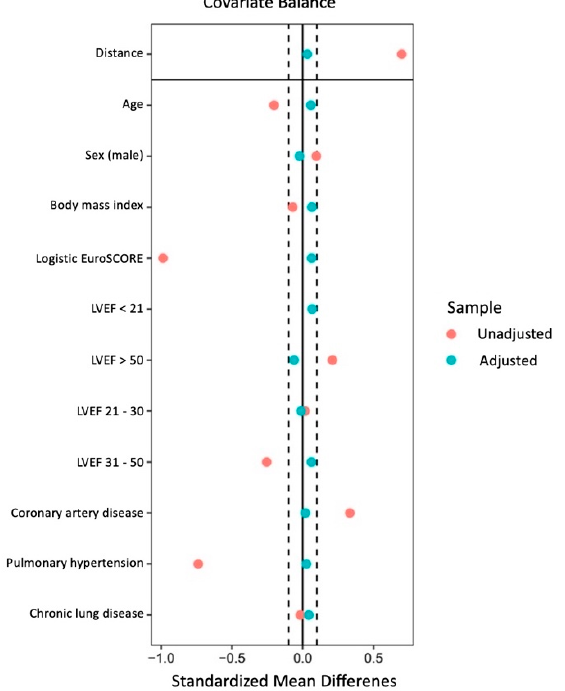
Figure 1. Covariate balance of the matching parameters before and after adjustment.